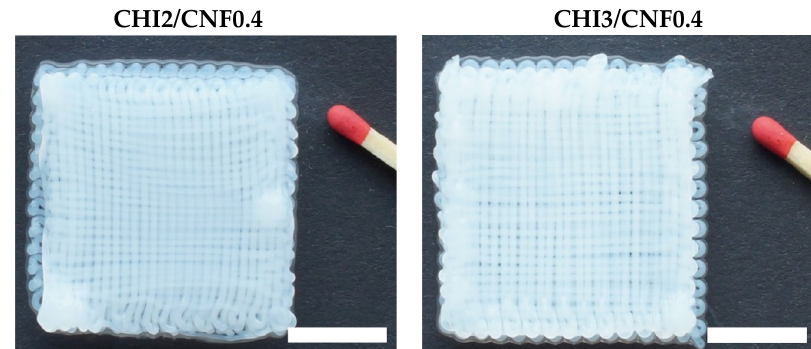
Figure 8. The 3D printed scaffolds of chitosan/cellulose nanofiber hydrogels with 30 × 30 mm 2 and 0.85 mm interfilament distance. Scale bars: 11.5 mm.